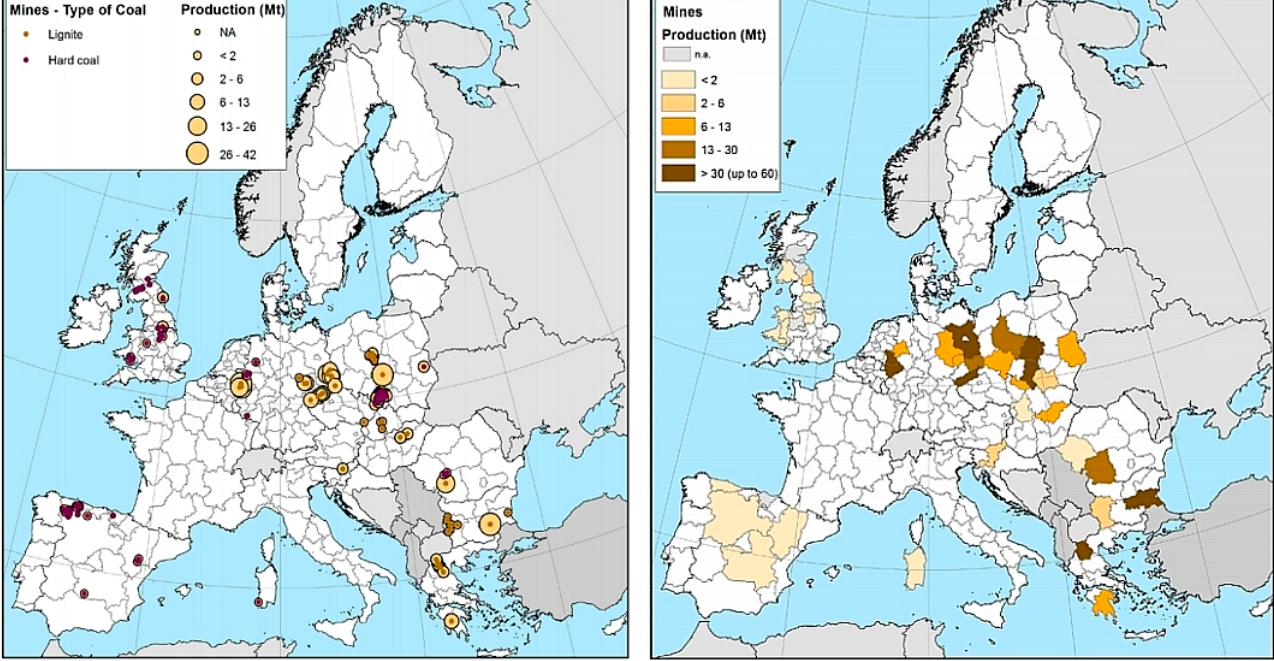
Figure 1. Locations of active lignite and hard coal mines in the European Union ( left ), and the annual production of coal mines in NUTS-2 regions in the European Union ( right ) [Source: EU coal regions: opportunities and challenges ahead].